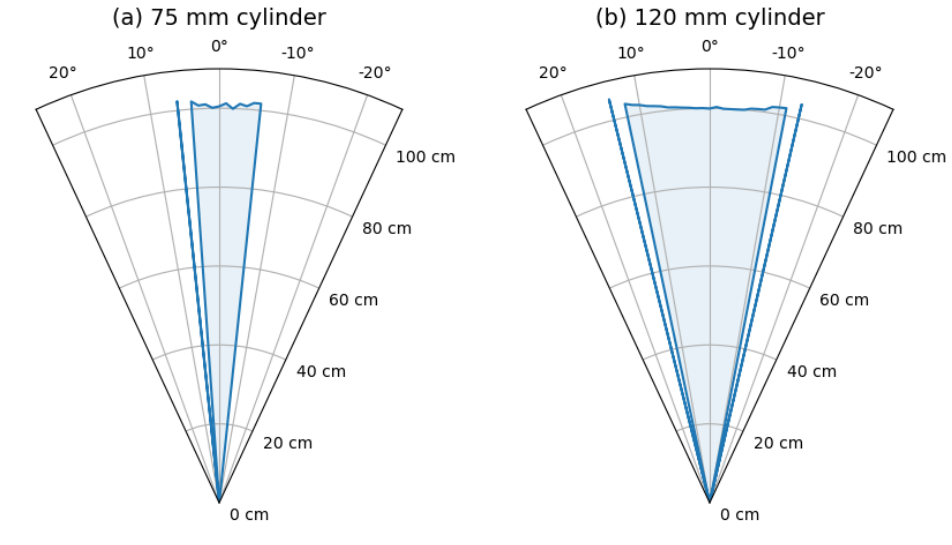
Figure 9. Polar plot of median values for each angle. ( a ) Left panel for the 75 mm cylinder. ( b ) Right panel for the 120